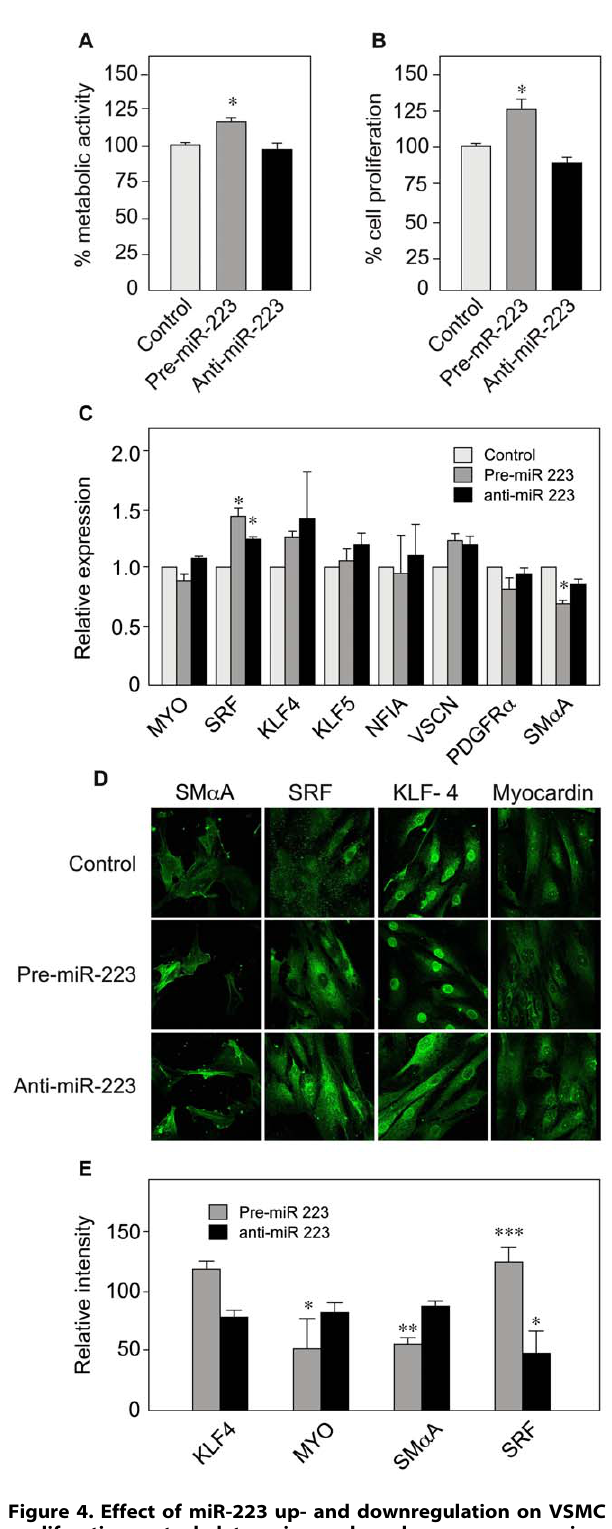
Figure 4. Effect of miR-223 up- and downregulation on VSMC proliferation, cytoskeleton size and marker gene expression. To upregulate and knock-down the expression of miR-223, VSMCs were transfected using pre-miR-223 and anti-miR-223, respectively. After 48h of transfection, cells were assayed for metabolic activity (A), cell proliferation (B) and marker gene expression levels (with RT-qPCR) (C). Data are presented as the mean 6 SD of triplicates. One representative experiment is shown (n=2). (D) Immunostaining of VSMC protein markers. (E) Quantification of the immunofluorescence data from